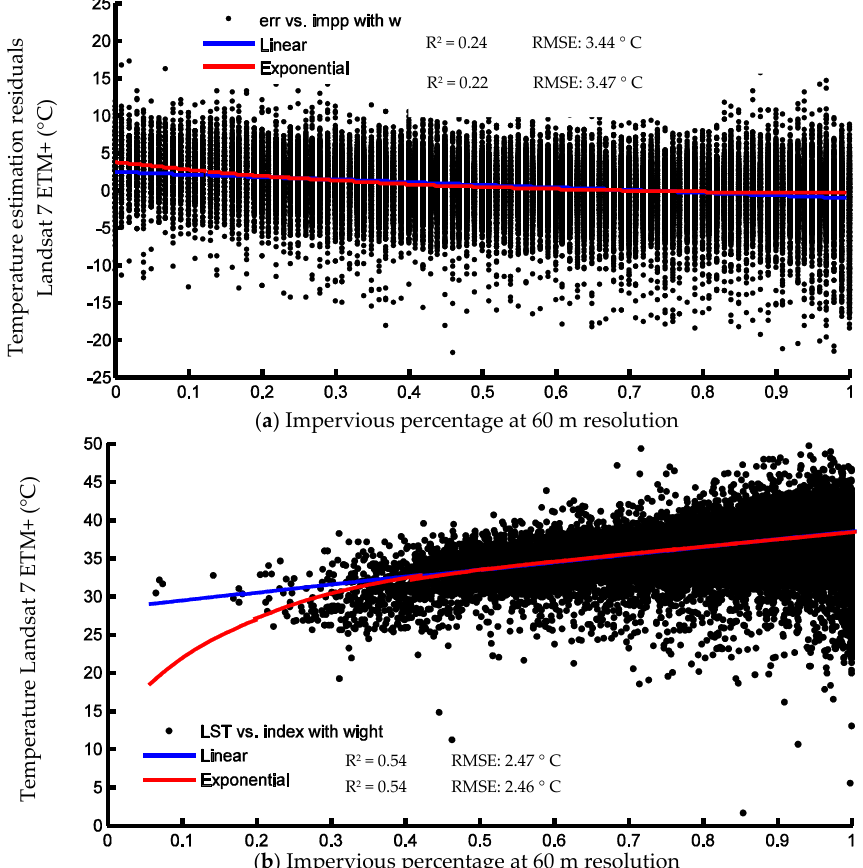
Figure 8. Linear (blue line) and exponential (red line) fits between temperature estimation residuals of Landsat 7 ETM+ and impervious percentage. ( a ) original DisTrad function; and ( b ) improved temperature estimation residuals’ disaggregation method.